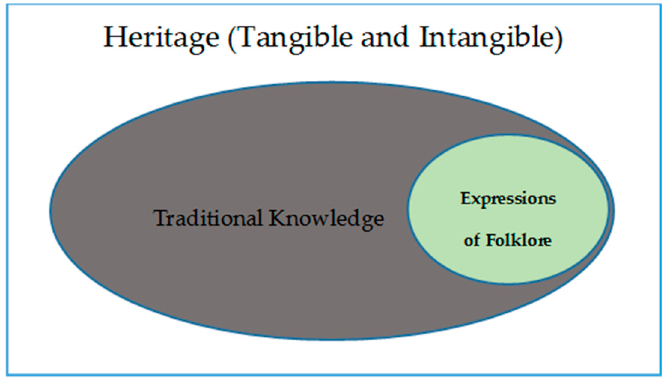
Figure 1. The relationship between heritage, traditional knowledge, and traditional expressions.